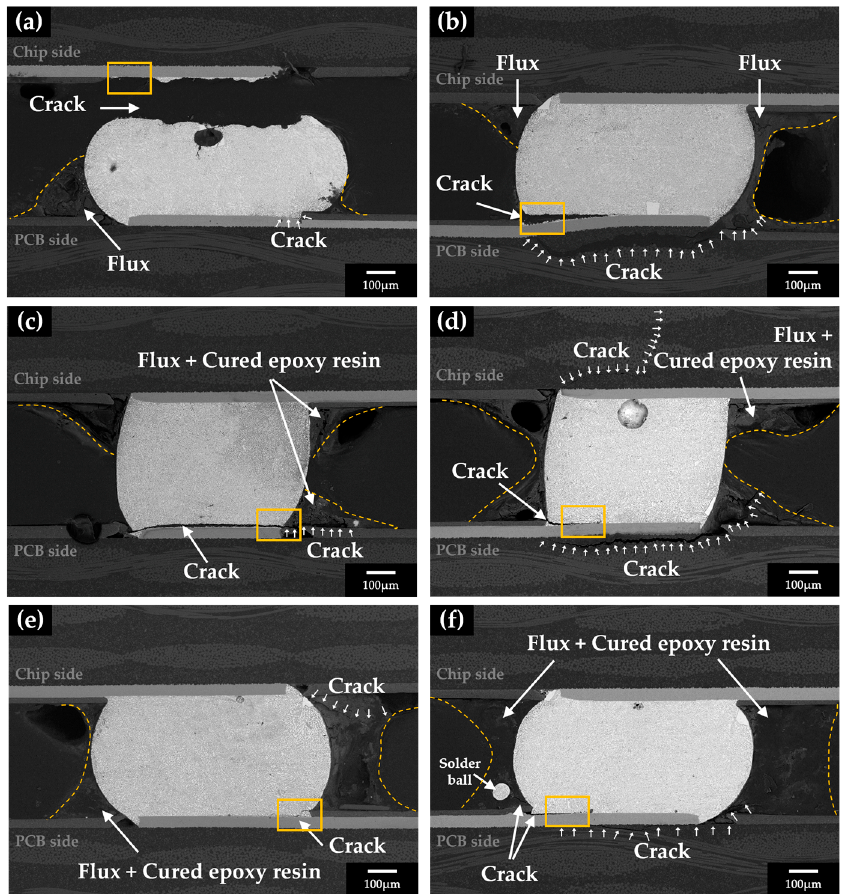
Figure 9. The typical failures of solder joints after the board level drop test: ( a , b ) Sn–Bi/Sn–Bi, ( c , d ) Sn–Bi/TSEP Sn–Bi-3, ( e ) Sn–Bi/TSEP Sn–Bi-5, ( f ) Sn–Bi/TSEP Sn–Bi-7. ( c , d ) Sn–Bi/TSEP Sn–Bi-3, ( e ) Sn–Bi/TSEP Sn–Bi-5, ( f ) Sn–Bi/TSEP